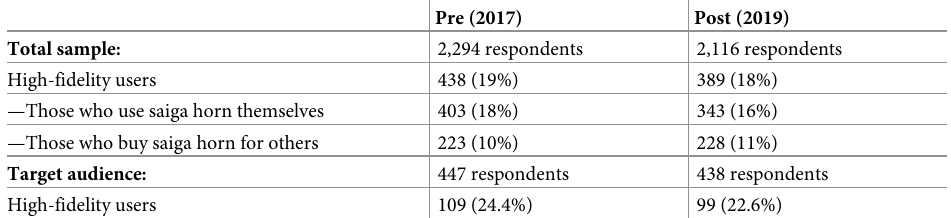
Table 2. Comparing high-fidelity saiga horn user frequencies pre- and post-intervention. The proportion of high- fidelity users in the total sample, and the target audience specifically, are shown.